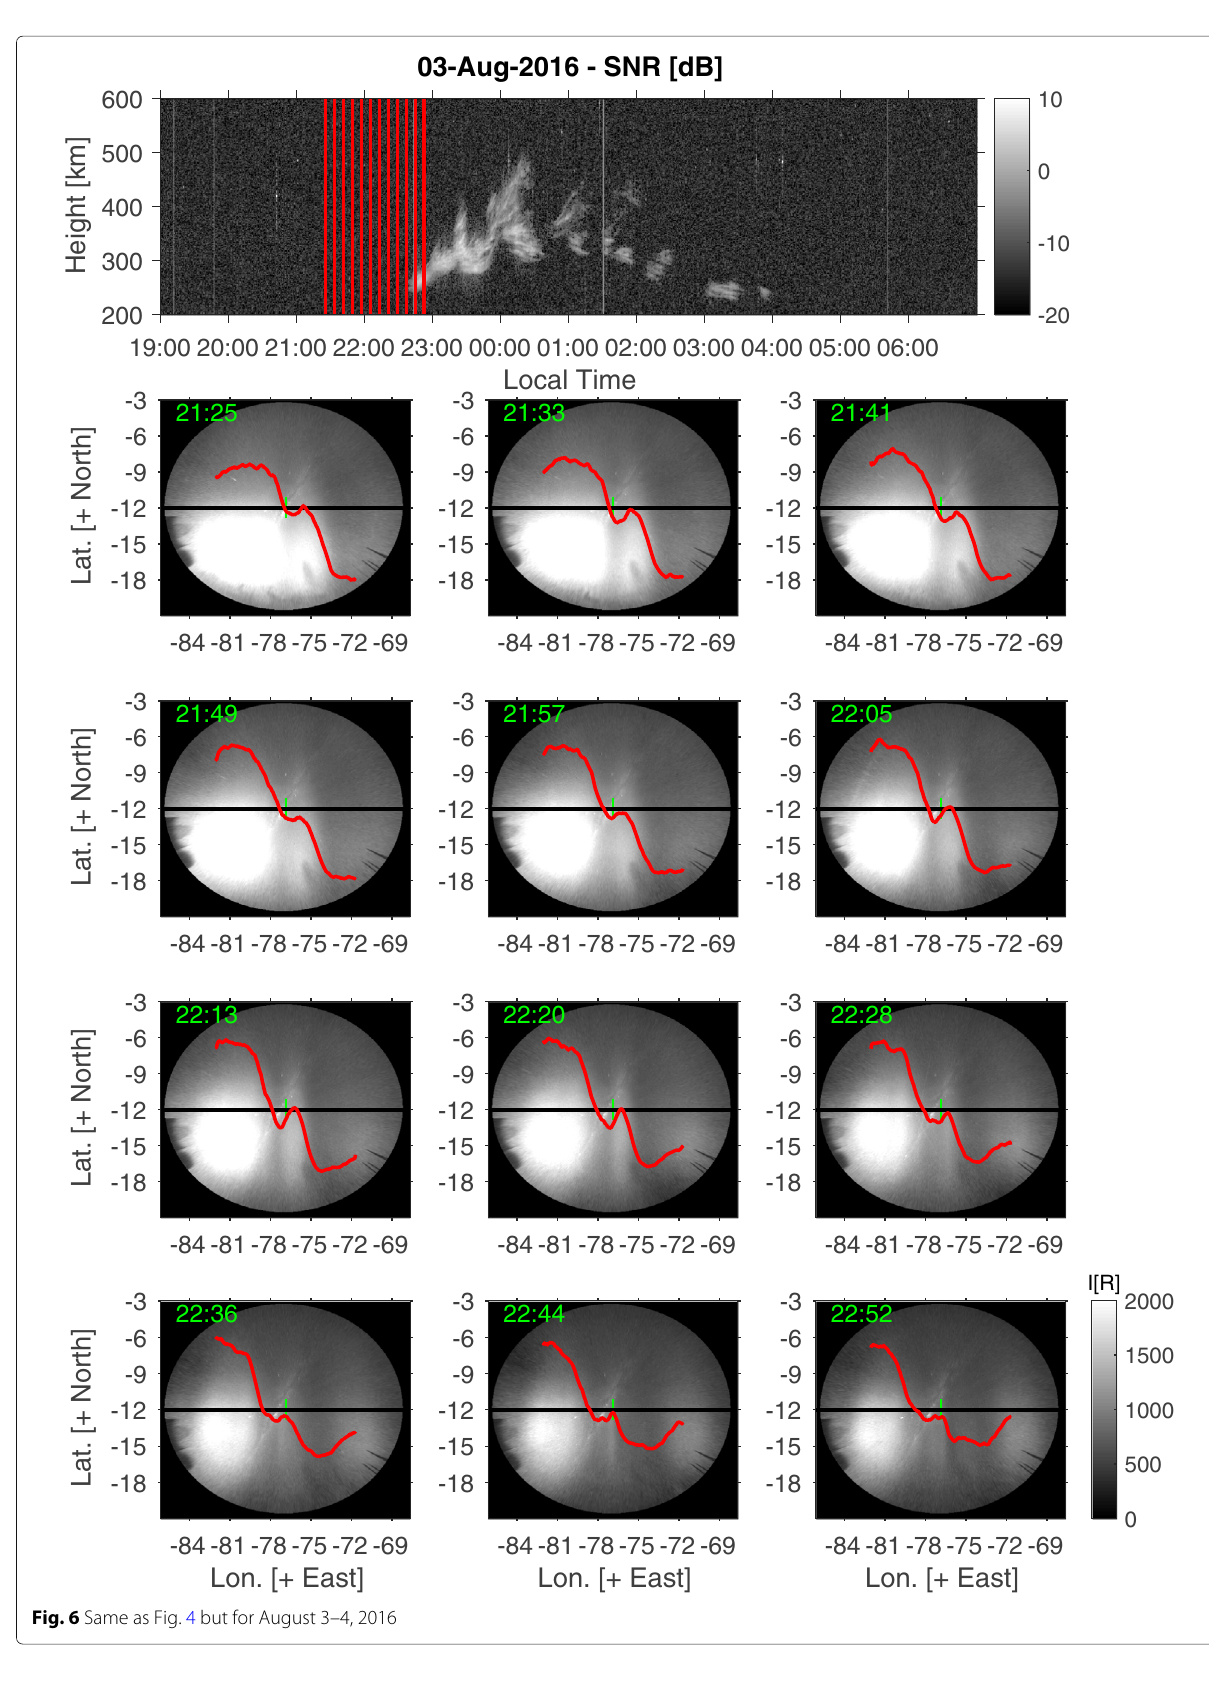
Fig. 6 Same as Fig. 4 but for August 3–4,